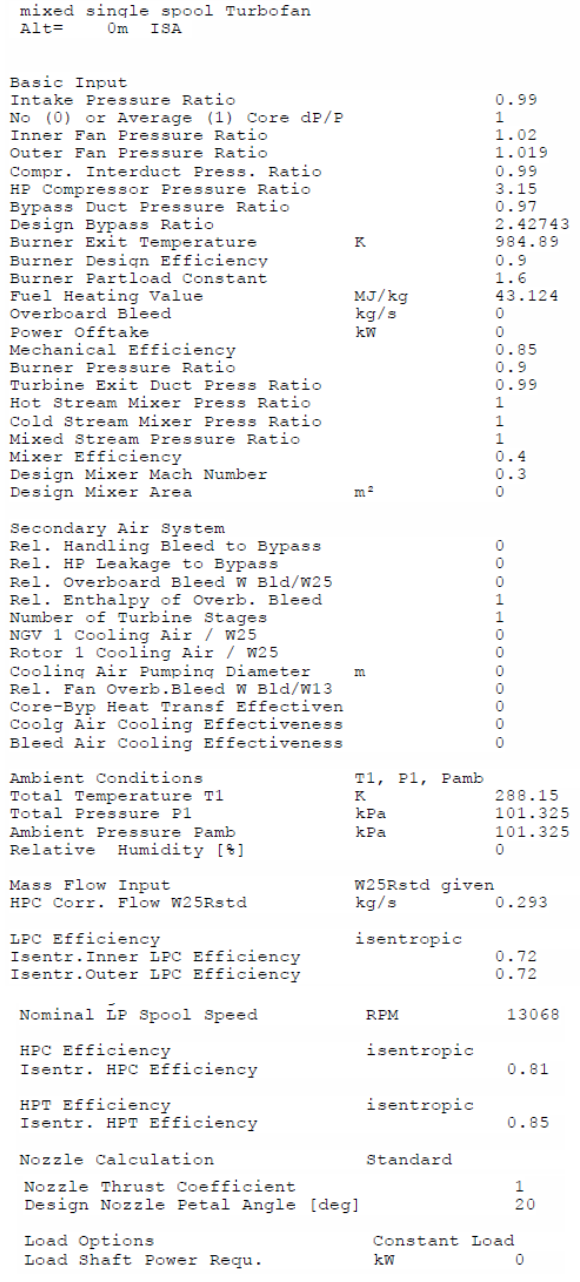
Figure A7. GasTurb Turbofan engine model input parameters—fan at 13,068 RPM.